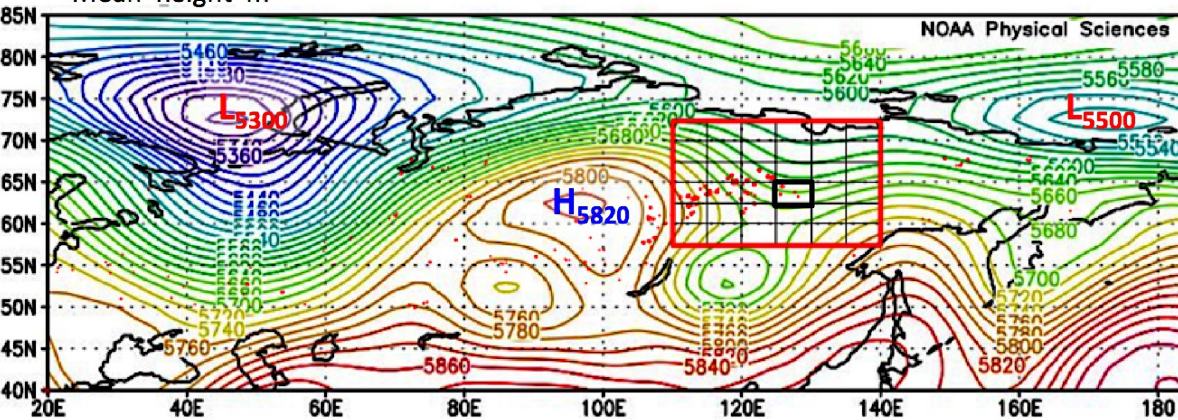
Figure 4. Large meandering of westerlies on 24 July. The study region (Sakha) is shown by the rectangle with the red line. HFA is shown by the rectangle with the thick black line. The hotspot (HS) is shown by the red dot.